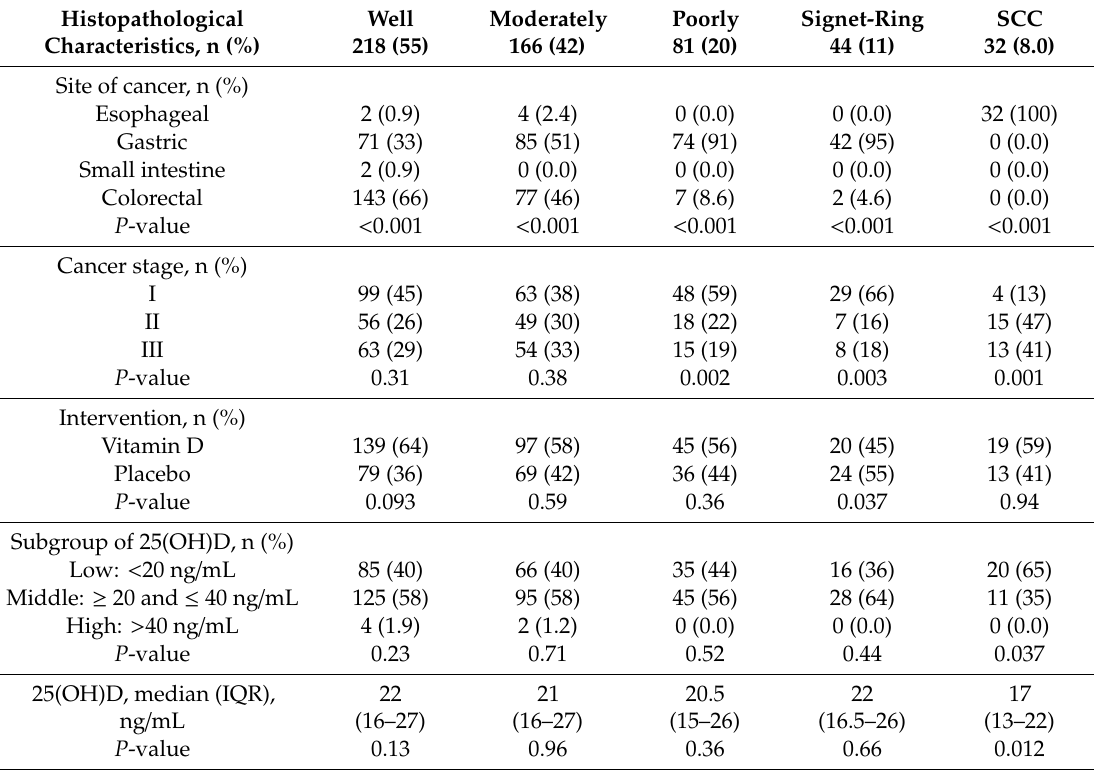
Table 1. Patient demographics in subgroups stratified by histopathological characteristics